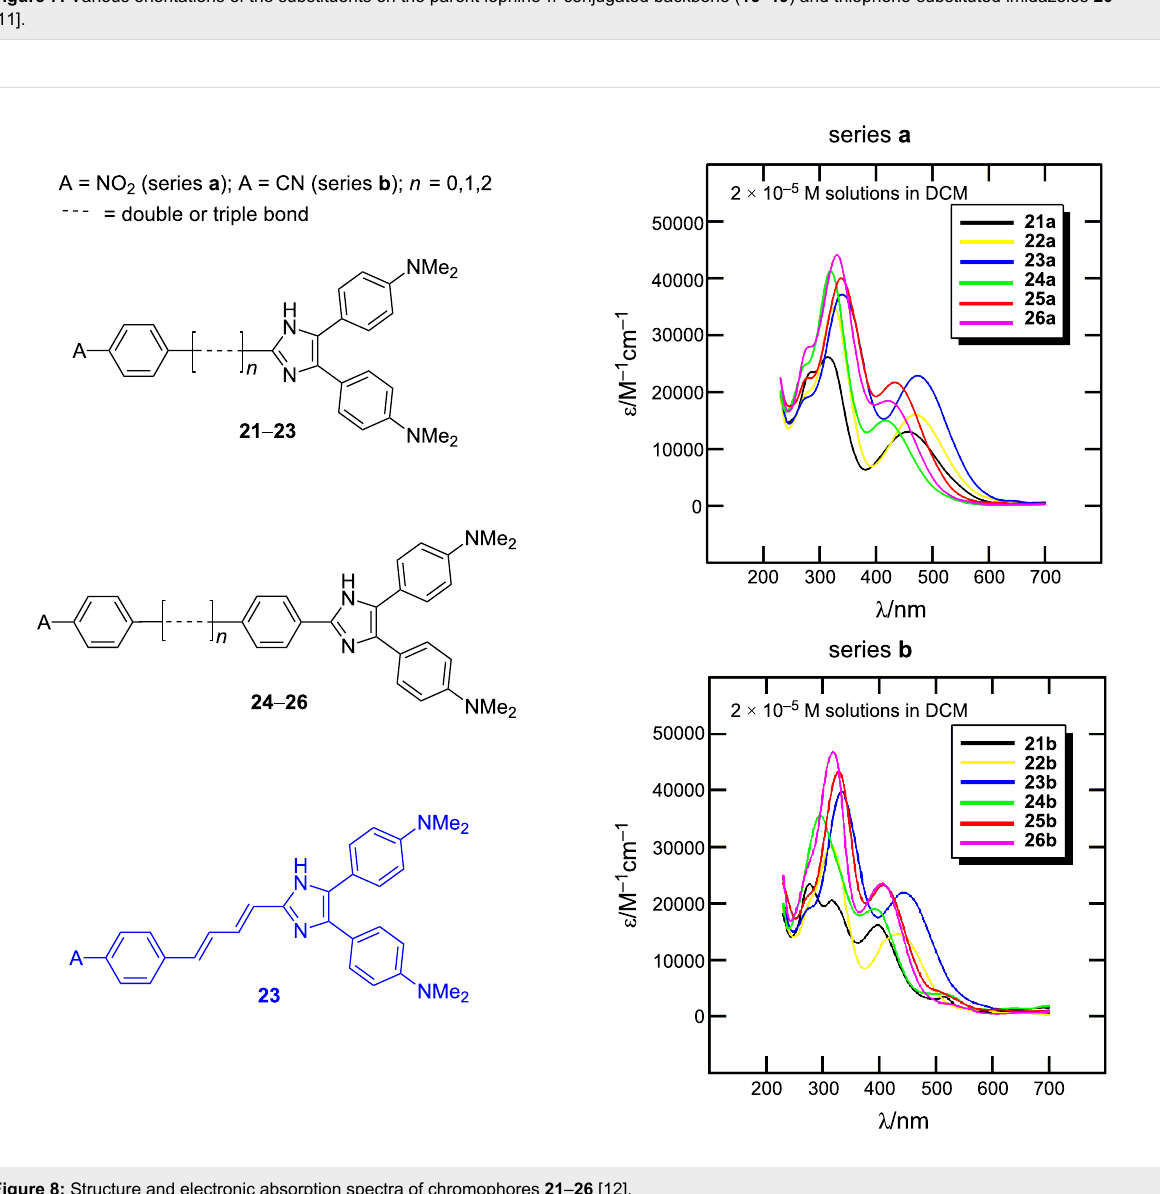
Figure 7: Various orientations of the substituents on the parent lophine π -conjugated backbone ( 16 – 19 ) and thiophene-substituted imidazoles 20 [11].